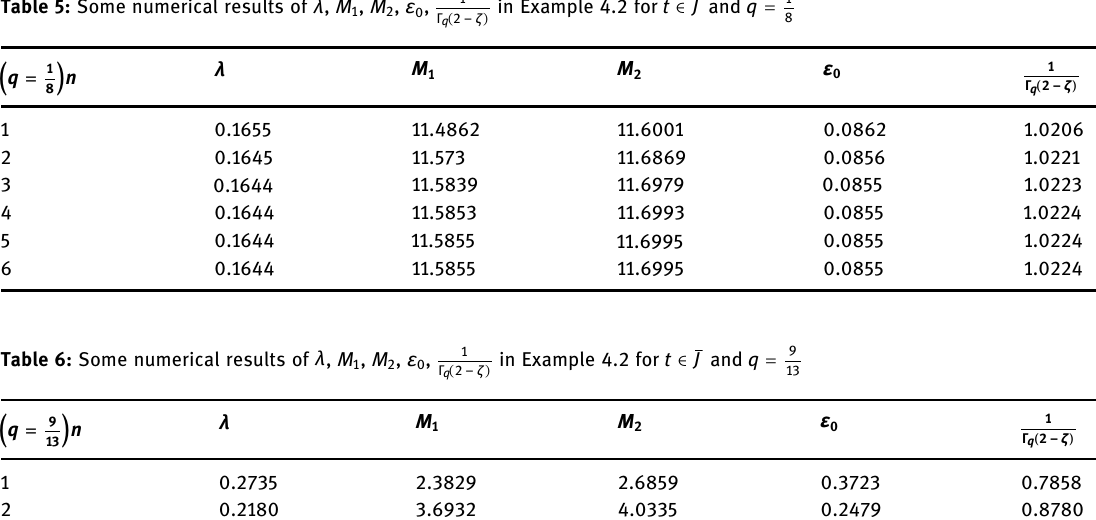
Table 5: Some numerical results of λ , M 1 , M 2 , ε 0 ,